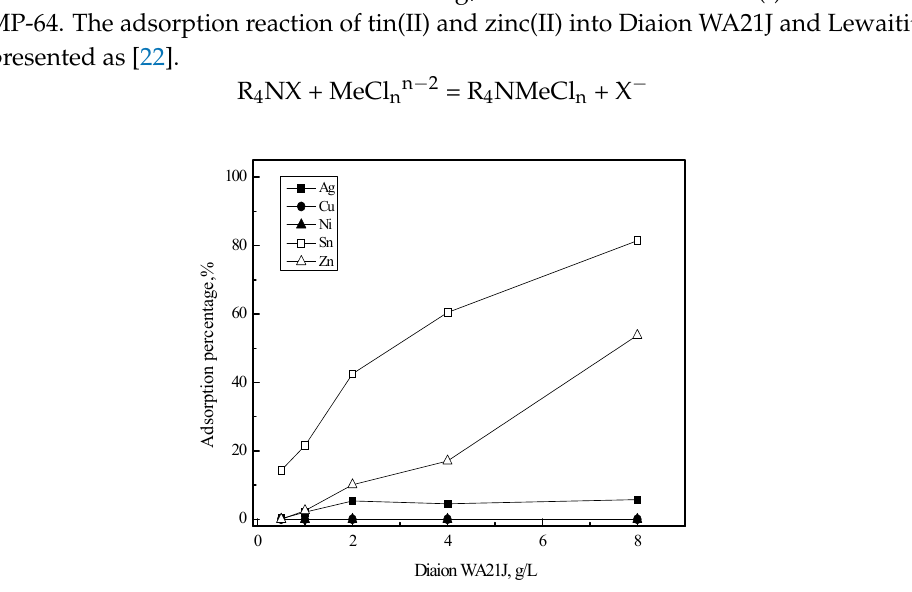
Figure 4. Effect of Diaion WA21J concentration on the adsorption of metals in 5 M HCl solution. [Diaion WA21J] = 0.5–8 (g/L), time = 6 h, shaking speed = 200 rpm.